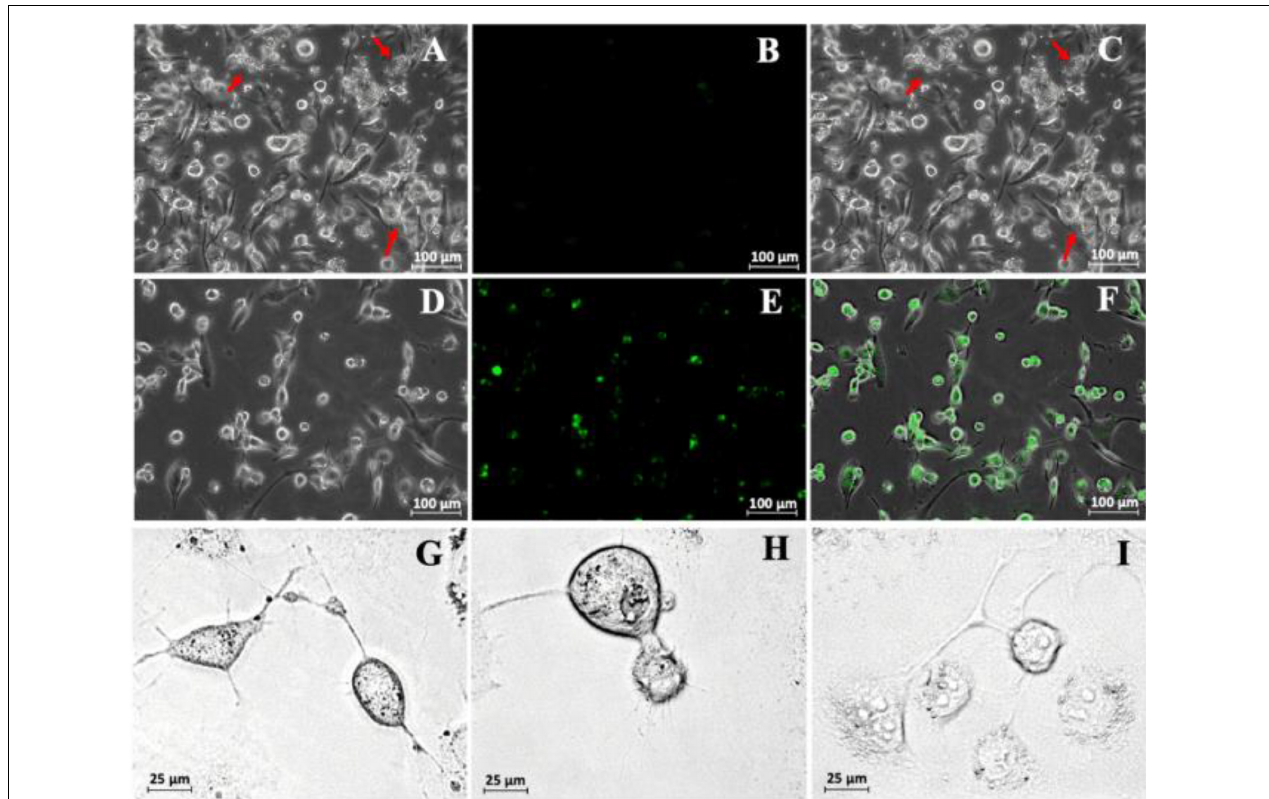
FIGURE 5 | (A) Transfection of THP-1-derivated macrophage M2 with DNA-extracellular vesicles (Evs). A bright-field image was taken just after the infection of DNA-EVs. The red arrows indicate the DNA-EVs adhered together with macrophages and also on cell culture surfaces. (B) Fluorescence image with no green signal. (C) Overlay of bright-field and fluorescence images. Further images were taken after 36 h transfection: bright field (D) , fluorescence (E) , overlay (F) . Images to see the stretch of macrophage arms to capture EVs on the cell culture surfaces were taken after 6 h (G) , 12 h (H) , and 96 h (I)